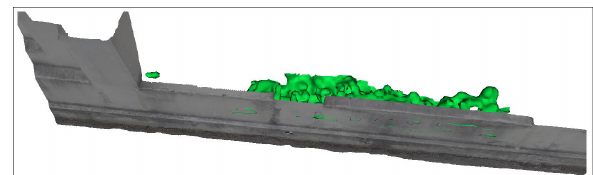
Figure 12. Integration of color-textured mesh and GPR iso- amplitude surfaces for the riverside